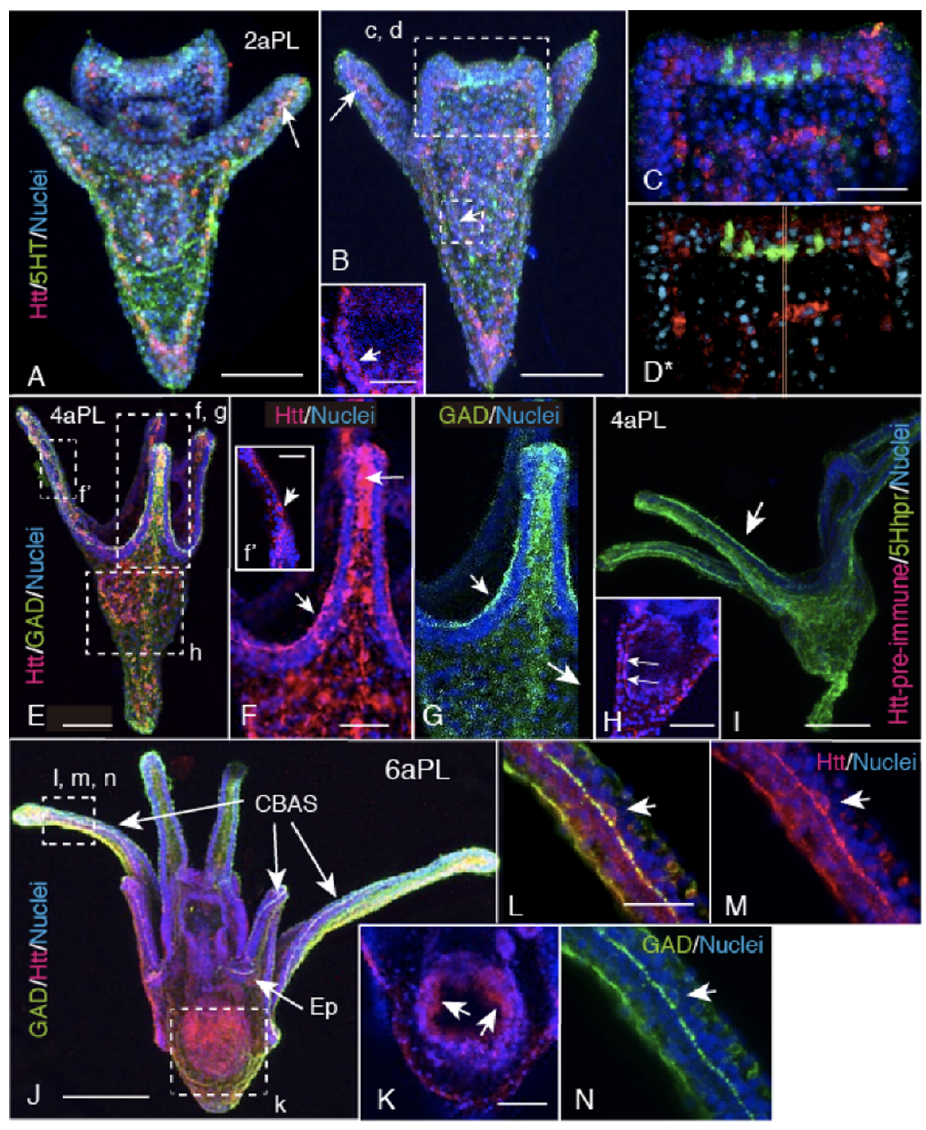
Figure 3. Confocal microscopy of triple- and double-stained plutei [Hp-Htt; red, serotonin (5HT); green, Serotonin receptor (5HThpr), green, GAD; green, and nuclei; blue)] showing the merged distribution of Hp-Htt-expressing cells and the CBAS during the pluteus stage. Hp-Htt-positive cells (red) distribution was seen in the blastocoel on the basal surface of the ectoderm, and along the larval skeleton. ( A ) Ventral view of the triple stained 2aPL. Arrow: Hp-Htt-positive cells along the spicule. ( B ) Dorsal view. The Hp-Htt-positive cells being infiltrated into the ectoderm around the serotonergic apical ganglion (green). Arrow: Hp-Htt-positive cells were aligned along the arm spic- ule. ( C ) Higher magnification image of an apical ganglion region shown by a rectangle (c, d) in ( B ). Some of the Hp-Htt-positive cells near the apical ganglion shifted their position to the apical surface of the ectoderm. ( D* ) Animation of the same area as ( C ) shows spatial relations between Hp-Htt- positive cells and the apical ganglion. ( E ) In 4aPL, Hp-Htt-positive signals (red) and GAD-positive signals (green) were detected together in the CBAS, and in some of the blastocoelar cells. ( F ) Higher magnification of a rectangle (f, g) in ( E ) shows the CBAS (arrow). Long arrow: Hp-Htt-positive spic- ule tip area. Inset (f’): A higher magnification image of a rectangle (f’) in ( E ) showing a cytoplasmic Hp-Htt-positive signal along the axonal region and near the nuclei (arrow) in the CBAS. ( G ) The same area as ( F ) showing a GAD-positive signal (arrows). ( H ) A 3 µ m thick optical section at around the middle of the stomach indicated by a rectangle (h) in ( E ) shows higher magnification of the Hp- Htt-positive stomach wall (arrows). ( I ) Four-arm pluteus triple stained with pre-immune rabbit se- rum (red) as a negative control of Hp-Htt-staining and anti-5HThpr antibody (green) as a marker of the CBAS. ( J ) Six-arm pluteus triple stained for Hp-Htt (red), GAD (green), and DNA (blue). These two signals of Hp-Htt and GAD are converged to the CBAS (arrows). The same signal conversion is seen at the CBAS of the epaulette (Ep). ( K ) Five µ m thick optical cross-section around the middle